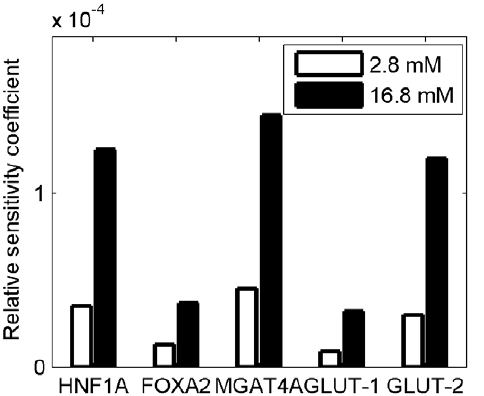
Figure 5. Therapeutic sensitivity analysis among pathway components. Steady-state sensitivity of GK rate in T2D cells with respect to elevation in the RNA abundance of the genes indicated, at two plasma glucose concentrations, as shown in the legend. The sensitivity coefficients are normalized with respect to the GK rate and abundance of the RNAs among b